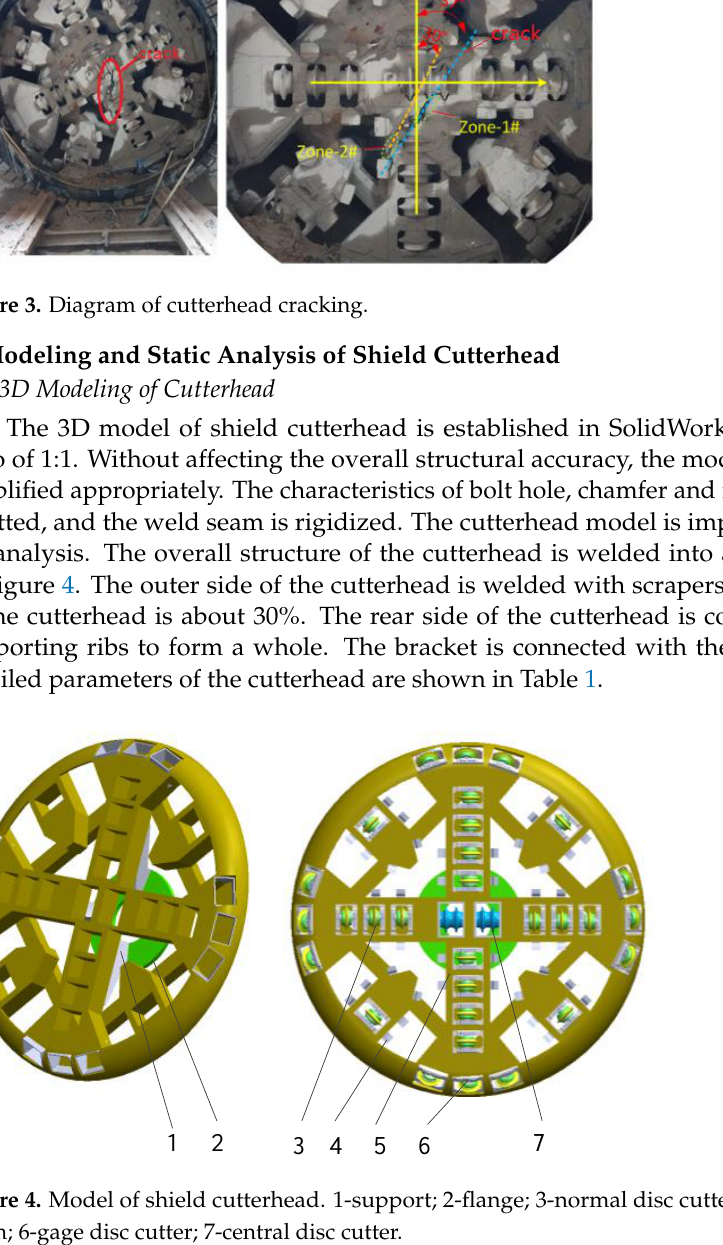
Figure 3. Diagram of cutterhead cracking.